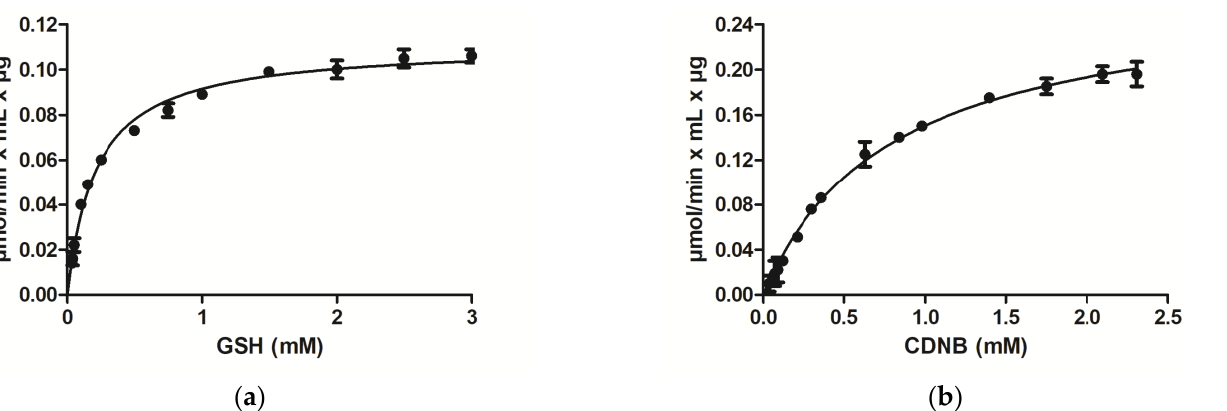
Figure 1. ( a ) Kinetics analysis of Mm GSTP1-1 using CDNB at saturated concentration and GSH varied. ( b ) Kinetics analysis of Mm GSTP1-1 using GSH at saturated concentration and CDNB varied.